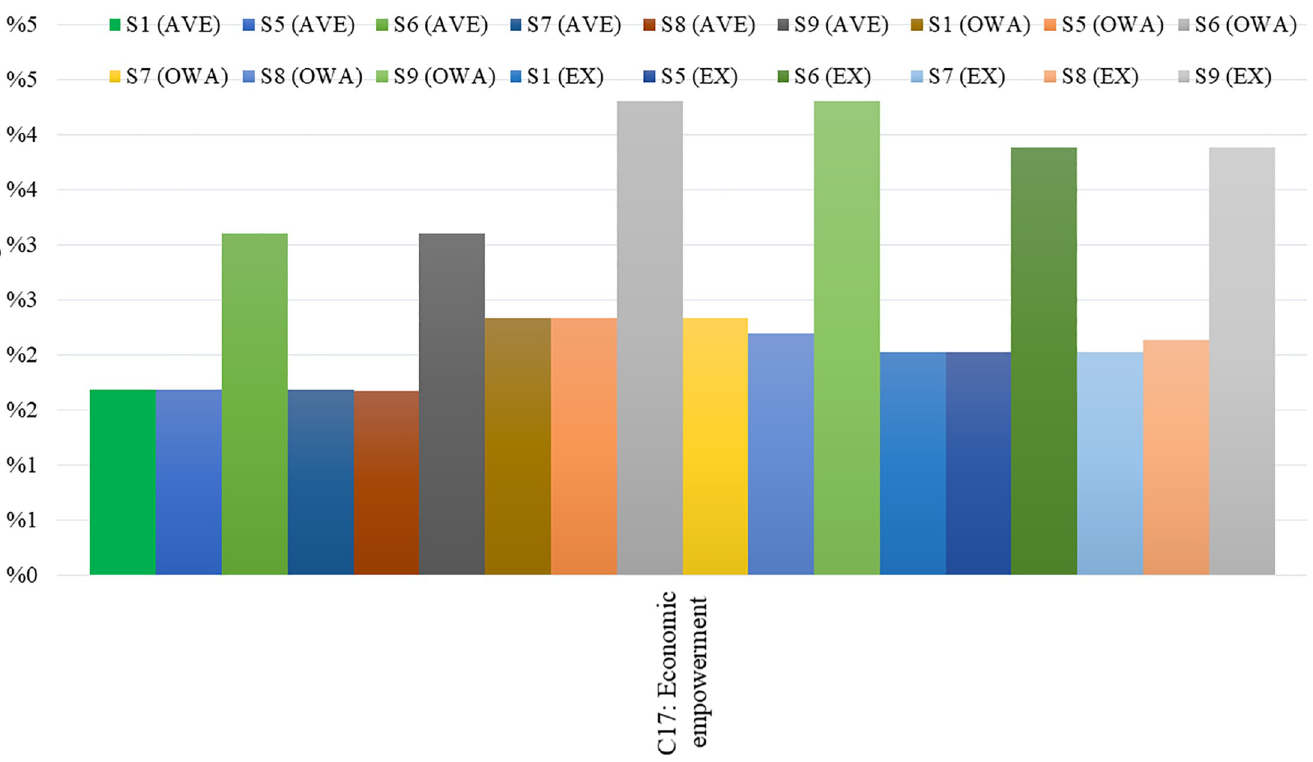
Fig 11. Outcome concept C17 percentage of change, considering confidences and